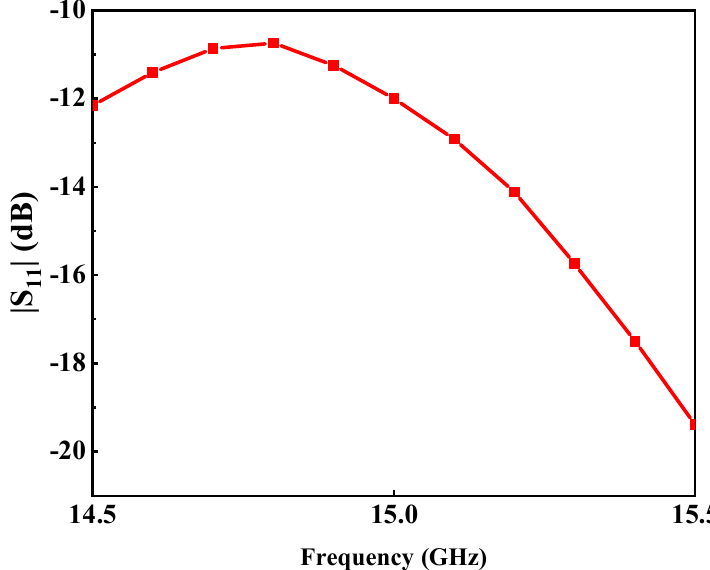
Figure 8. Measured reflection coefficients of the proposed antenna.